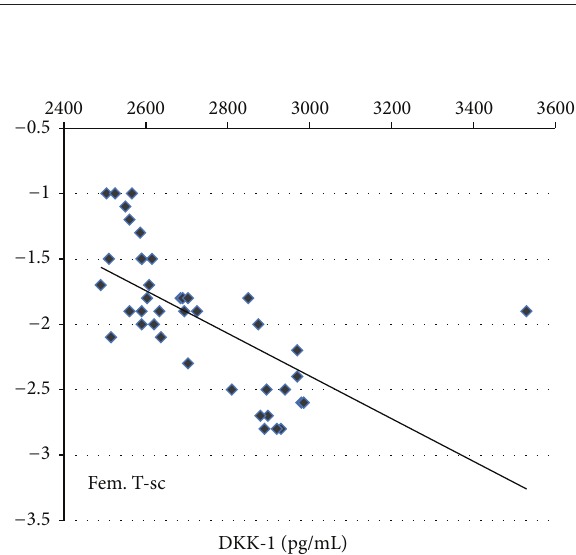
Figure 1: The positive correlation between serum DKK-1 levels and duration of postmenopause in both group I and group II.